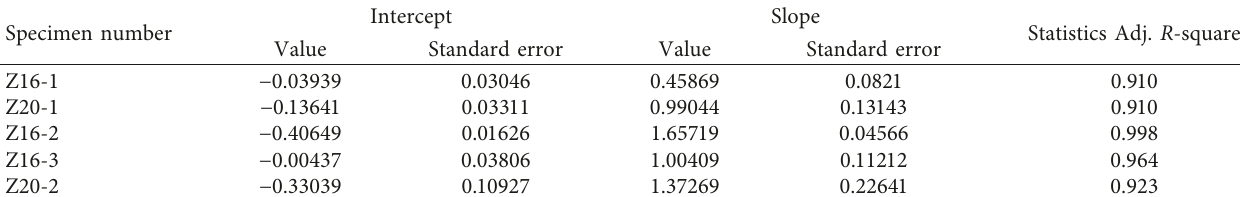
Table 10: Analysis report for the fitting parameters of the fitting